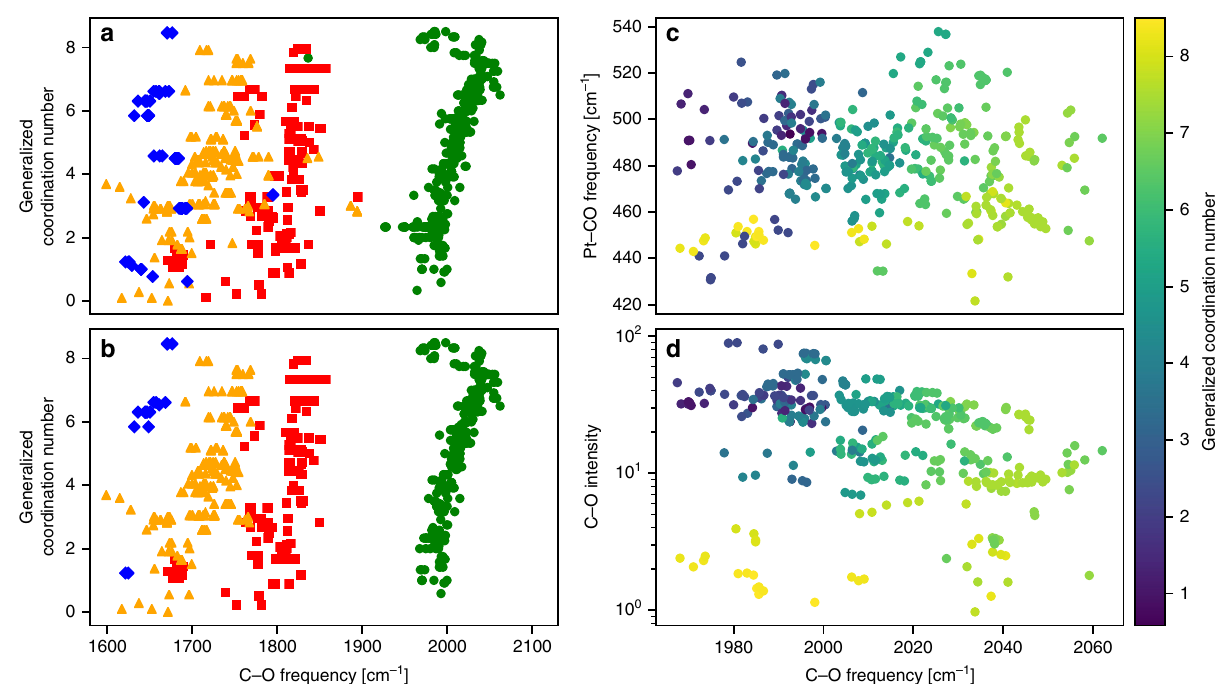
Fig. 3 Visualization of the primary DFT dataset and removal of outliers. a – d Data visualized in terms of the generalized coordination number (GCN), C-O frequencies, and/or intensities calculated for chemisorbed CO. a Primary data set. b Dataset after removing outliers (see text). Colors/shapes indicate GCN and frequency pairs for CO chemisorbed on atop (green/circles), bridge (red/squares), threefold (yellow/triangles) and fourfold (blue/square) sites. c , d 2D visualizations of chemisorbed Pt – CO stretch frequencies and intensities, respectively, at atop sites vs. the C – O stretch frequency. The color of the points indicates the value of the GCN depicted in the color map on the right. Colors go from low (violet) to high (yellow) values.